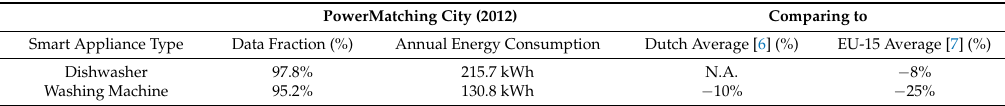
Table 6. Smart appliance electrical